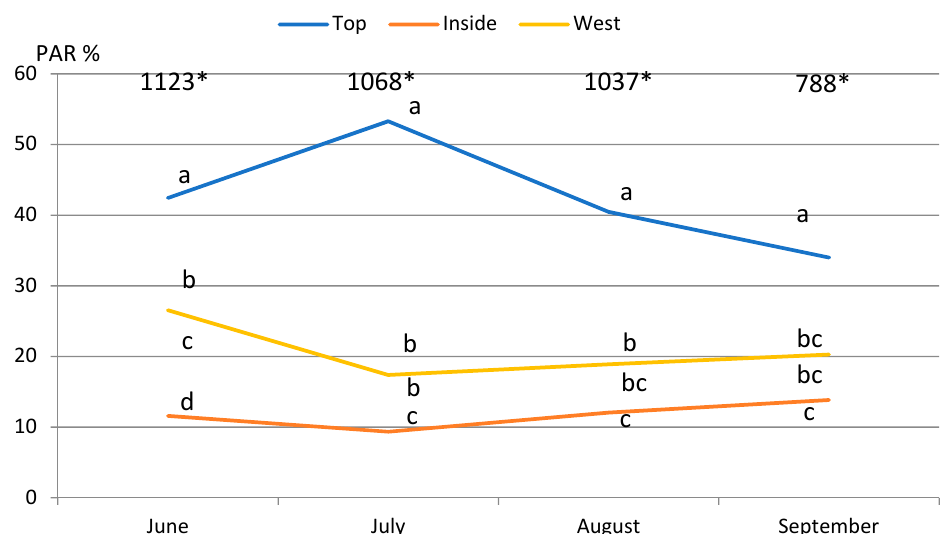
Figure 1. Available photosynthetically active radiation in different positions of the canopy, % from full light, average 2018–2020. The different letters at the same date indicate significant differences between canopy positions (Tukey’s (HSD) multiple range test at the confidence level p = 0.05), * average of open sky value, µ mol m − 2 s − 1.